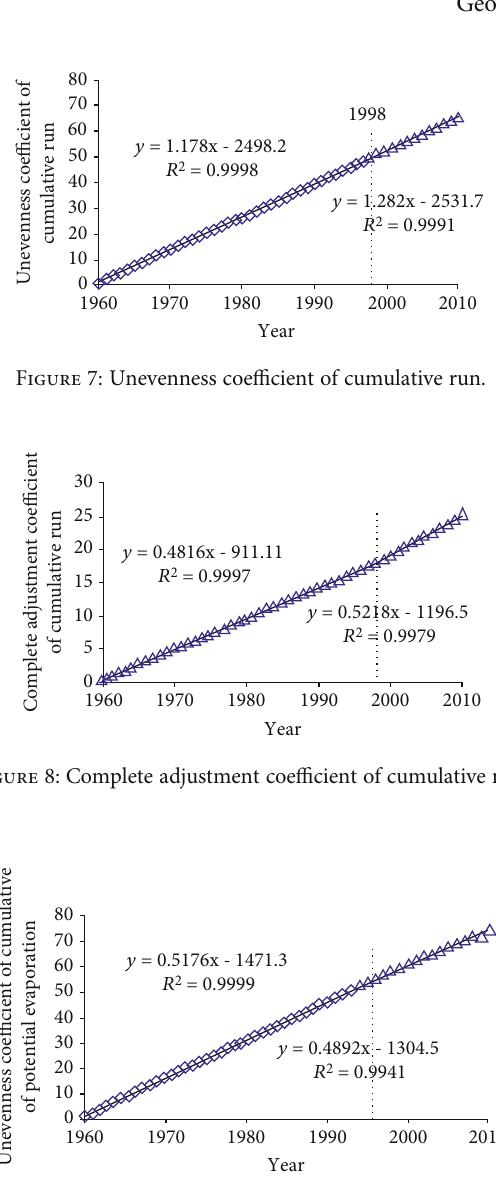
Figure 9: Unevenness coe ffi cient of cumulative of potential evaporation.